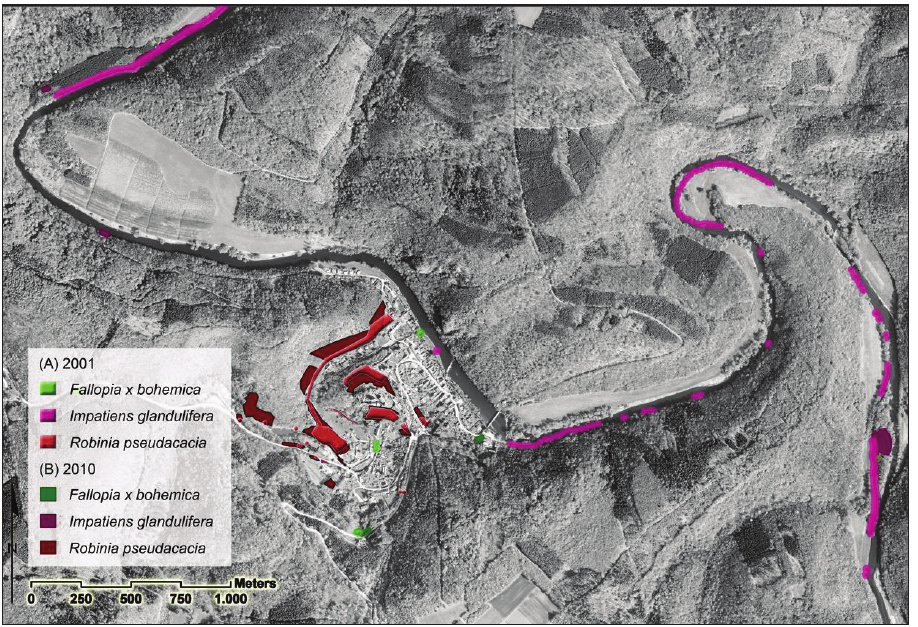
Figure 2. Changes in distribution of Fallopia × bohemica , Impatiens glandulifera and Robinia pseudoacacia between the first (2001) ( A ) and the second survey (2010) ( B ) in the surroundings of the village Hardegg. This section of the National Park Thayatal-Podyjí is the most heavily